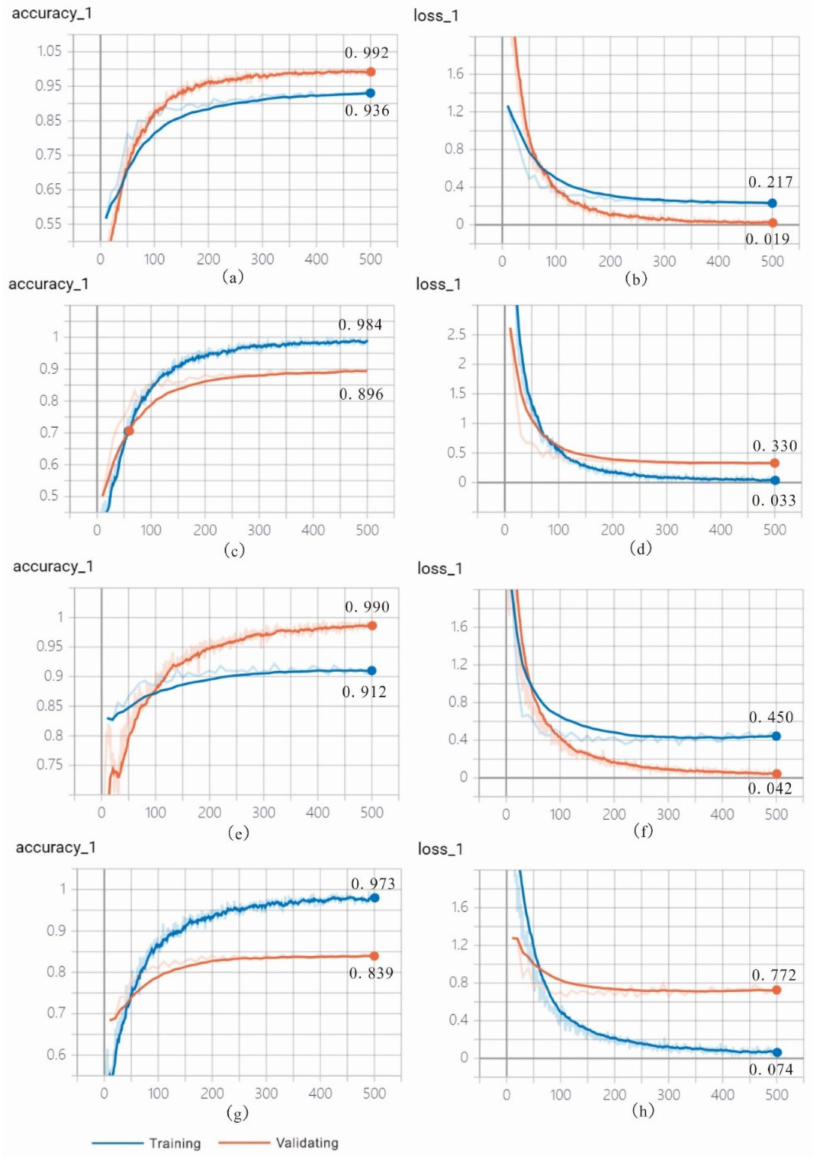
Figure 6. Comparison of training accuracy and loss of CNN model based on multi-scale training set: ( a , b ) shows the training model of ore-caused anomaly based on sentence training set; ( c , d ) shows the training model of ore-caused anomaly based on paragraph training set; ( e , f ) shows the training model of ore-causing anomaly based on sentence training set; ( g , h ) shows the training model of ore-causing anomaly based on paragraph training